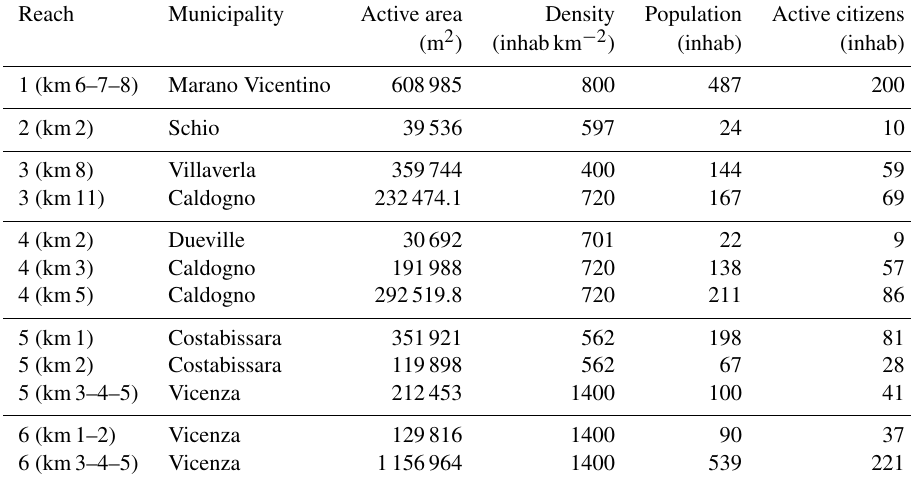
Table 5. Estimate of the active population that potentially can provide CS observations of W L with DySc sensors. Reach Municipality